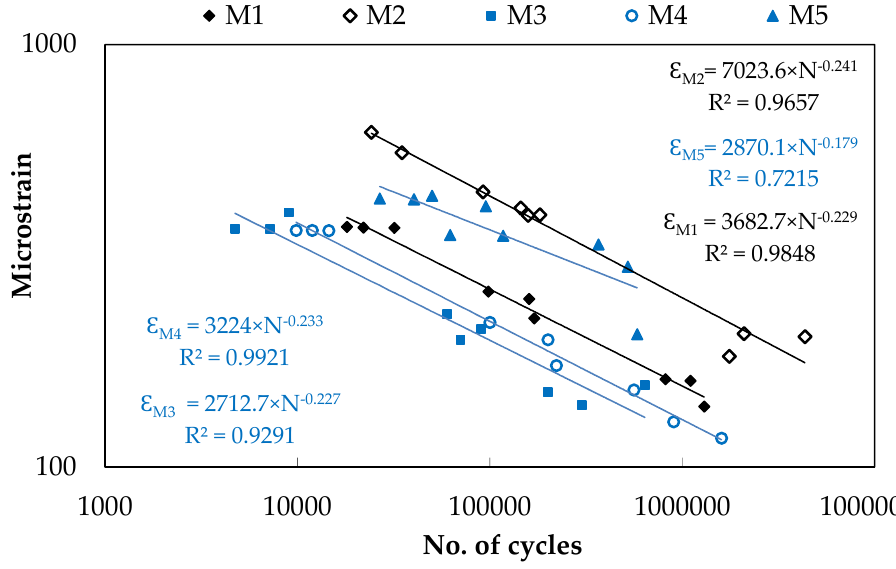
Figure 12. Fatigue cracking laws of the studied mixtures.